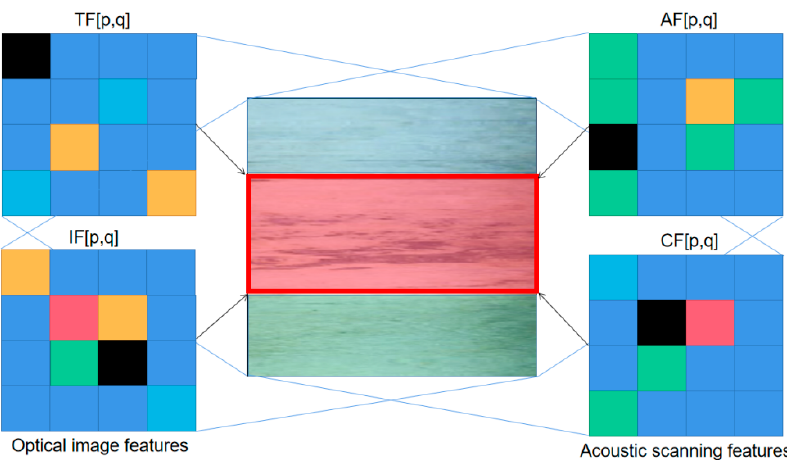
Figure 6. Identification block diagram of weak interlayer.